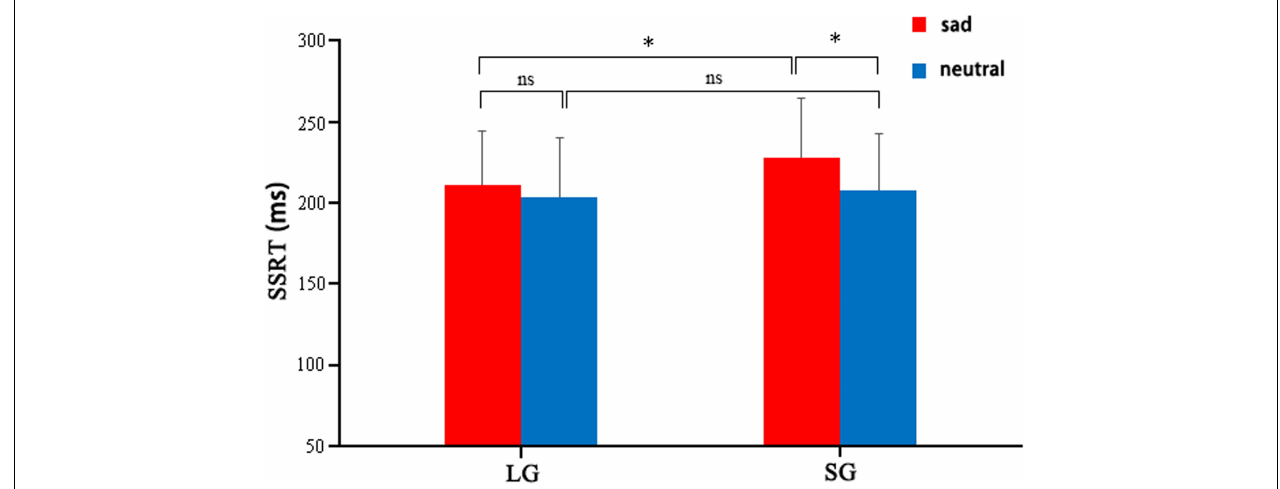
FIGURE 2 | Emotional Stop Signal Task (eSST) performance between LG and SG, by emotion condition (neutral, sad). eSST, emotional Stop Signal Task; SSRT, stop signal reaction time; LG, love group; SG, single group. ∗ p < 0.05; ns, not